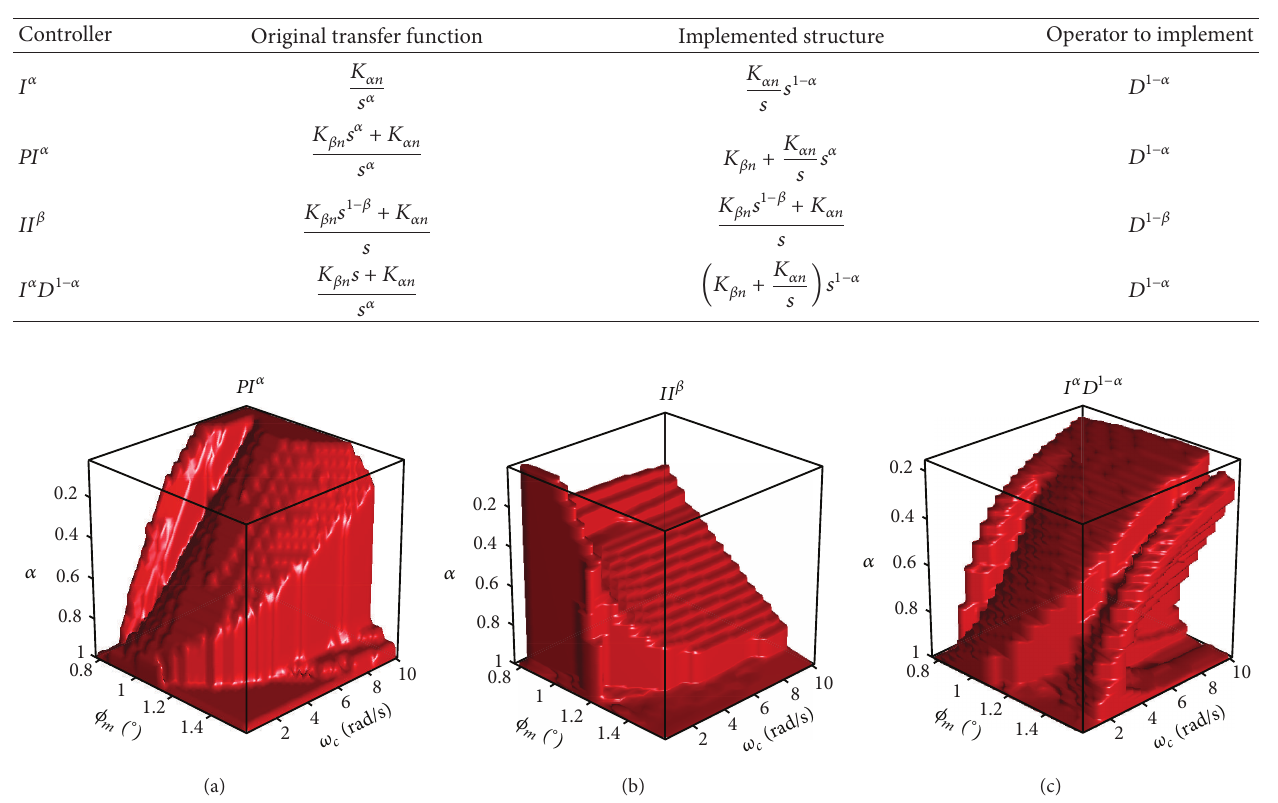
Table 2: Implementation of the controllers.